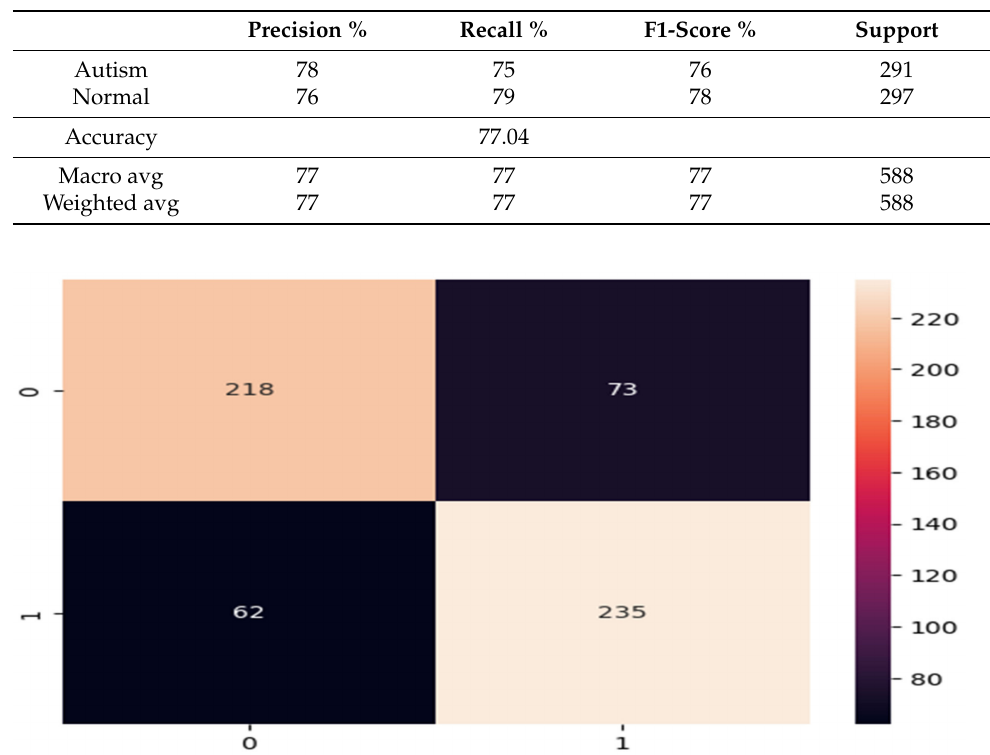
Table 8. Results of VGG-16 with MLPClassifier.